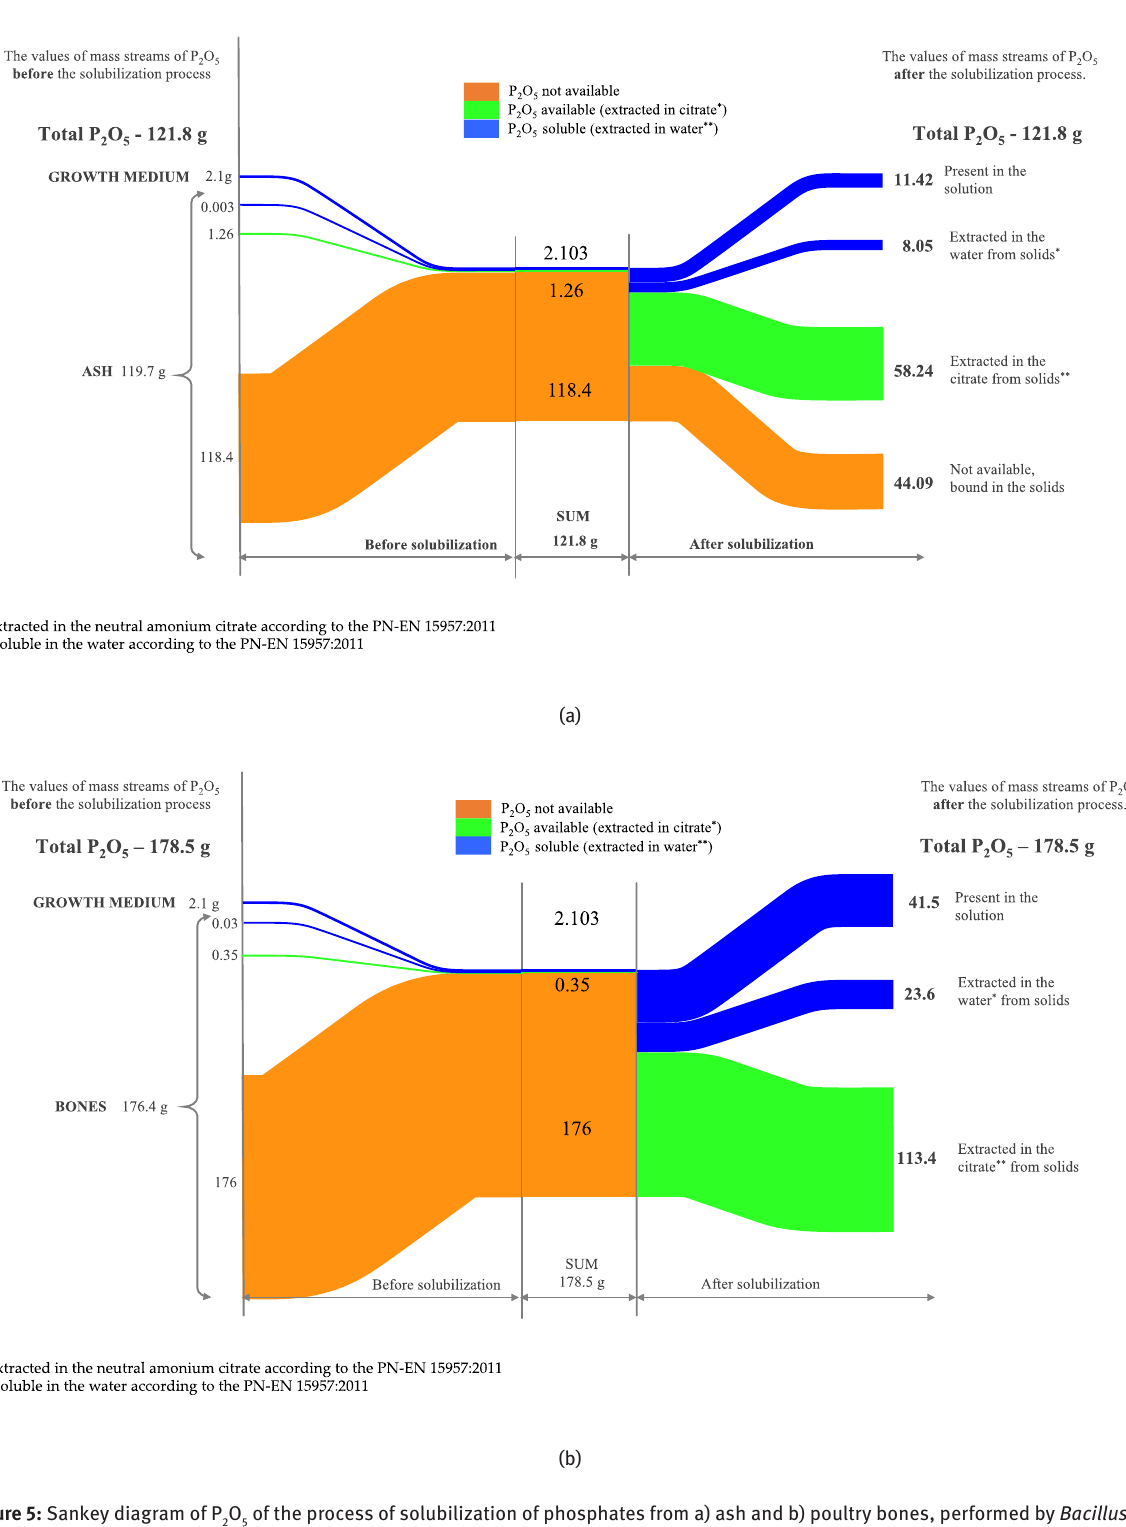
Figure 5: Sankey diagram of P